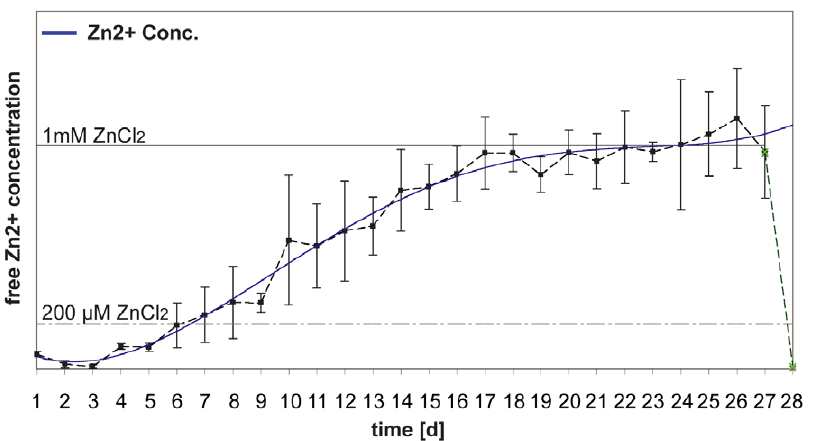
Figure 3. NPs release Zn 2 + over time. Quantification of the rate of zinc released from NPs in vitro by monitoring free zinc levels with Zinypr-1 fluorescence. The blue line indicates the trend-line for the obtained data-points. The green line shows an overall drop of fluorescence after treatment with TPEN that competitively binds free zinc with higher affinity. The fluorescence intensity of Zinpyr-1 was measured every 24 hrs and correlated to the fluorescence of medium with known zinc concentration.